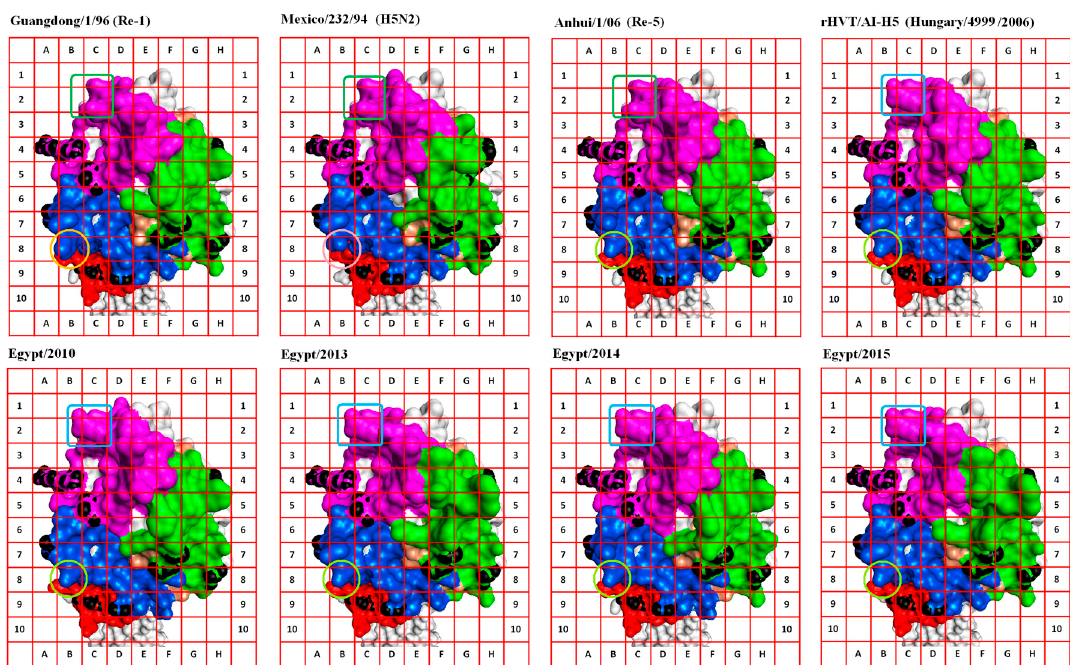
Figure 3. Visualization of AIV HA1 alternative functional configurations (AFC). Three-dimensional models of whole hemagglutinin (HA) molecules were generated using Phyre2 [45]. The whole HA sequence was used for modeling. The models were visualized using Accelrys ® Discovery Studio v4.1 software (Dassault Systèmes BIOVIA Corp., San Diego, CA, USA, Section 3.5). Sequence elements involved in VS formation were colored green, magenta, blue, and red according to the original coloring code of VS1-4, respectively [17]. The linear epitope sequences [28] were colored bronze. Models were synchronized and trimmed to present an optimum view of the VS. Conserved substructures identified as anchor sites (AS) (Table 1) were colored black, and docked on the grid to facilitate definition of AFC in terms of location and space occupied. Examples of AFC isoforms are highlighted using boxes or circles on the gird. Identical substructures (AFC isoforms) were highlighted using boxes or circles of the same color. The effect of both cis - and trans -amino acid substitutions was reflected on the AFC isoforms observed on each virus HA1 surface. AFC isoforms observed in the grid locations studied were used for complementing structural units (CSU) calculation (Section 2.6, Table 2, Figure 4).